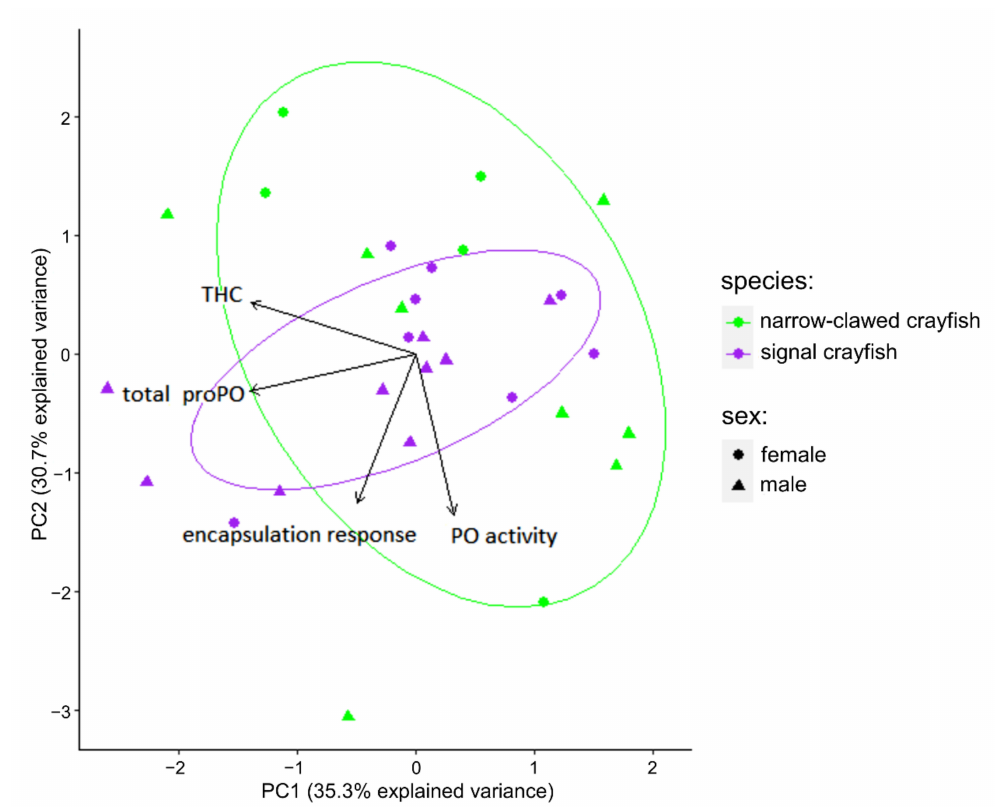
Figure 3. Principal component analysis (PCA) biplot on immune parameters of the signal crayfish and narrow-clawed crayfish from their mixed populations. Variables are indicated by black arrows, where their length represents the influence of a specific variable in shaping a model. 95% confidence ellipses are estimated around clusters. PO = phenoloxidaze, proPO = prophenoloxidaze, THC = total hemocyte